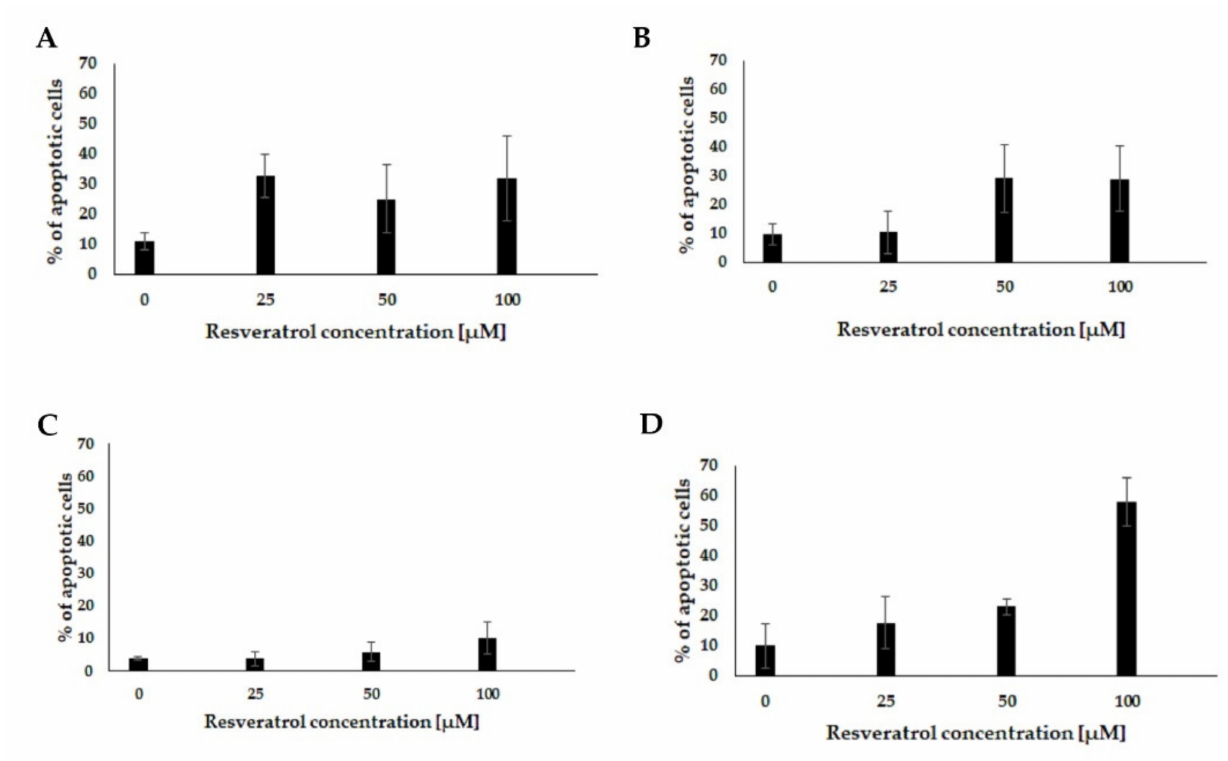
Figure 5. Detection of apoptotic cells using the TUNEL method. The number of apoptotic cells increases with the concentration of resveratrol in all cell lines: ( A ) EPP85-181P cell line, ( B ) EPP85-181RNOV cell line, ( C ) AsPC-1 cell line and ( D ) H6c7 cell